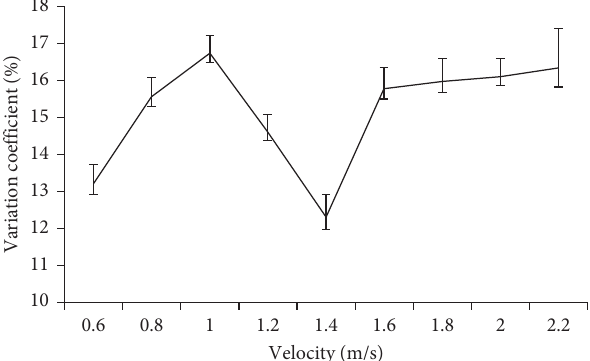
Figure 12: Plant spacing variation coefficient results.